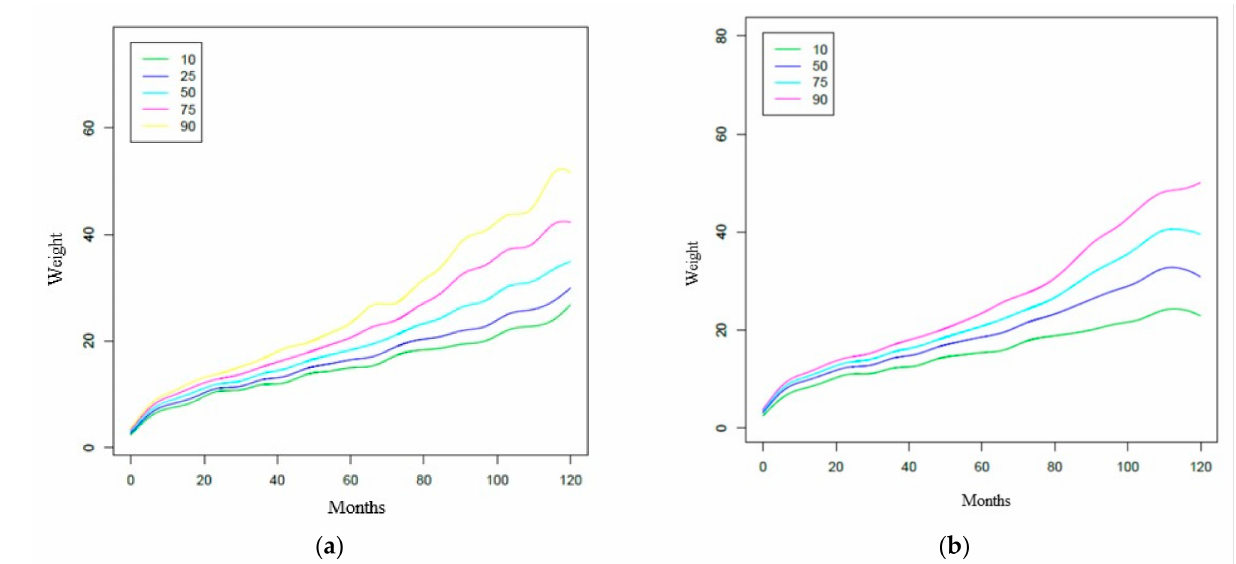
Figure 3. Percentile weight curves calculated with LMS method: ( a ) percentile weight curves in women; ( b ) percentile weight curves in men.